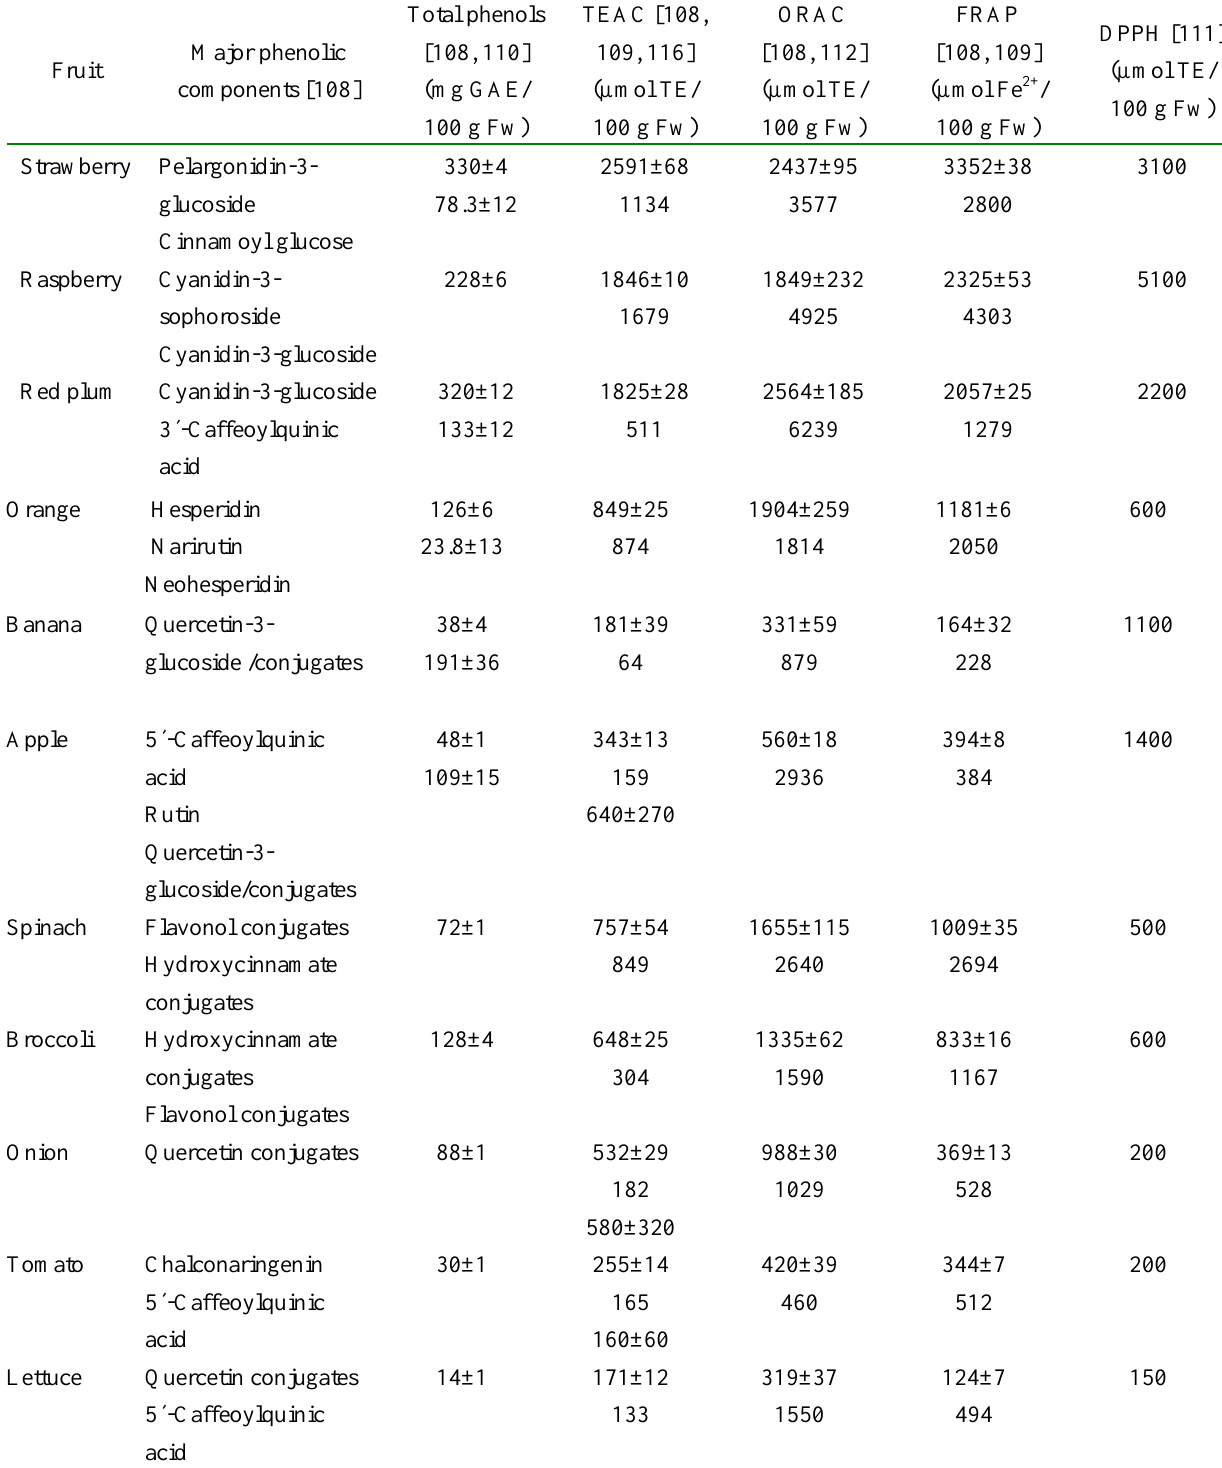
Table 2. Major phenolic components, total phenolic content, and total antioxidant capacity of some selected fruits and